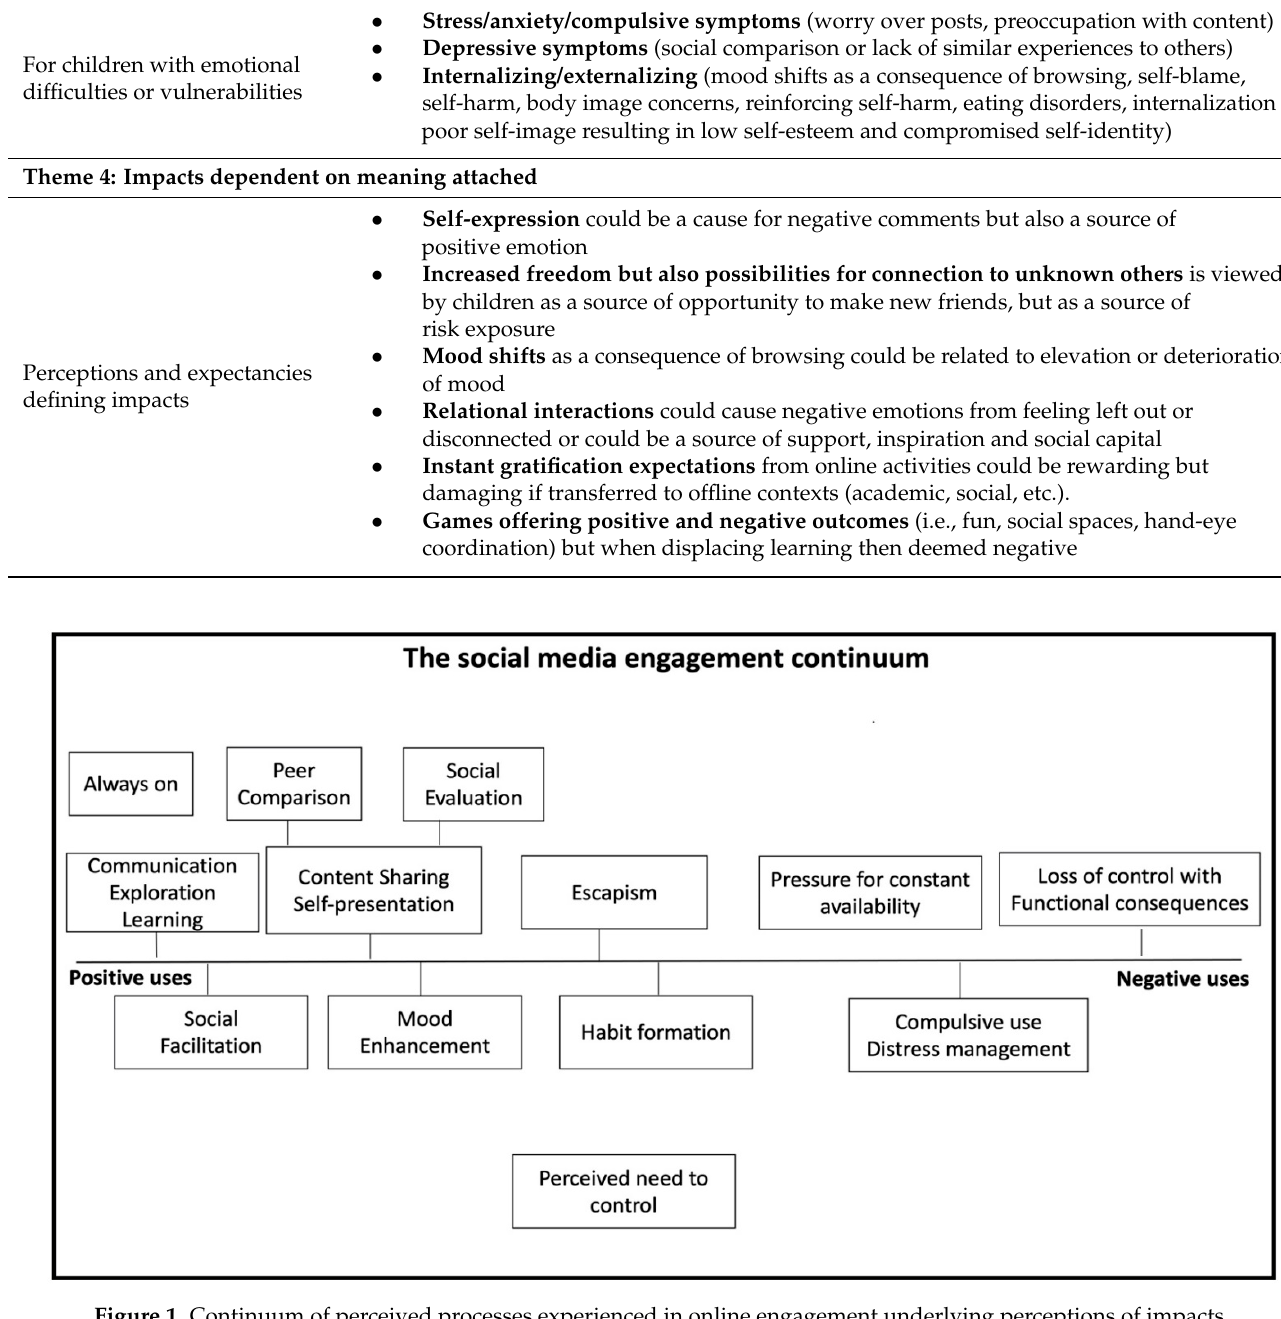
Figure 1. Continuum of perceived processes experienced in online engagement underlying perceptions of impacts.